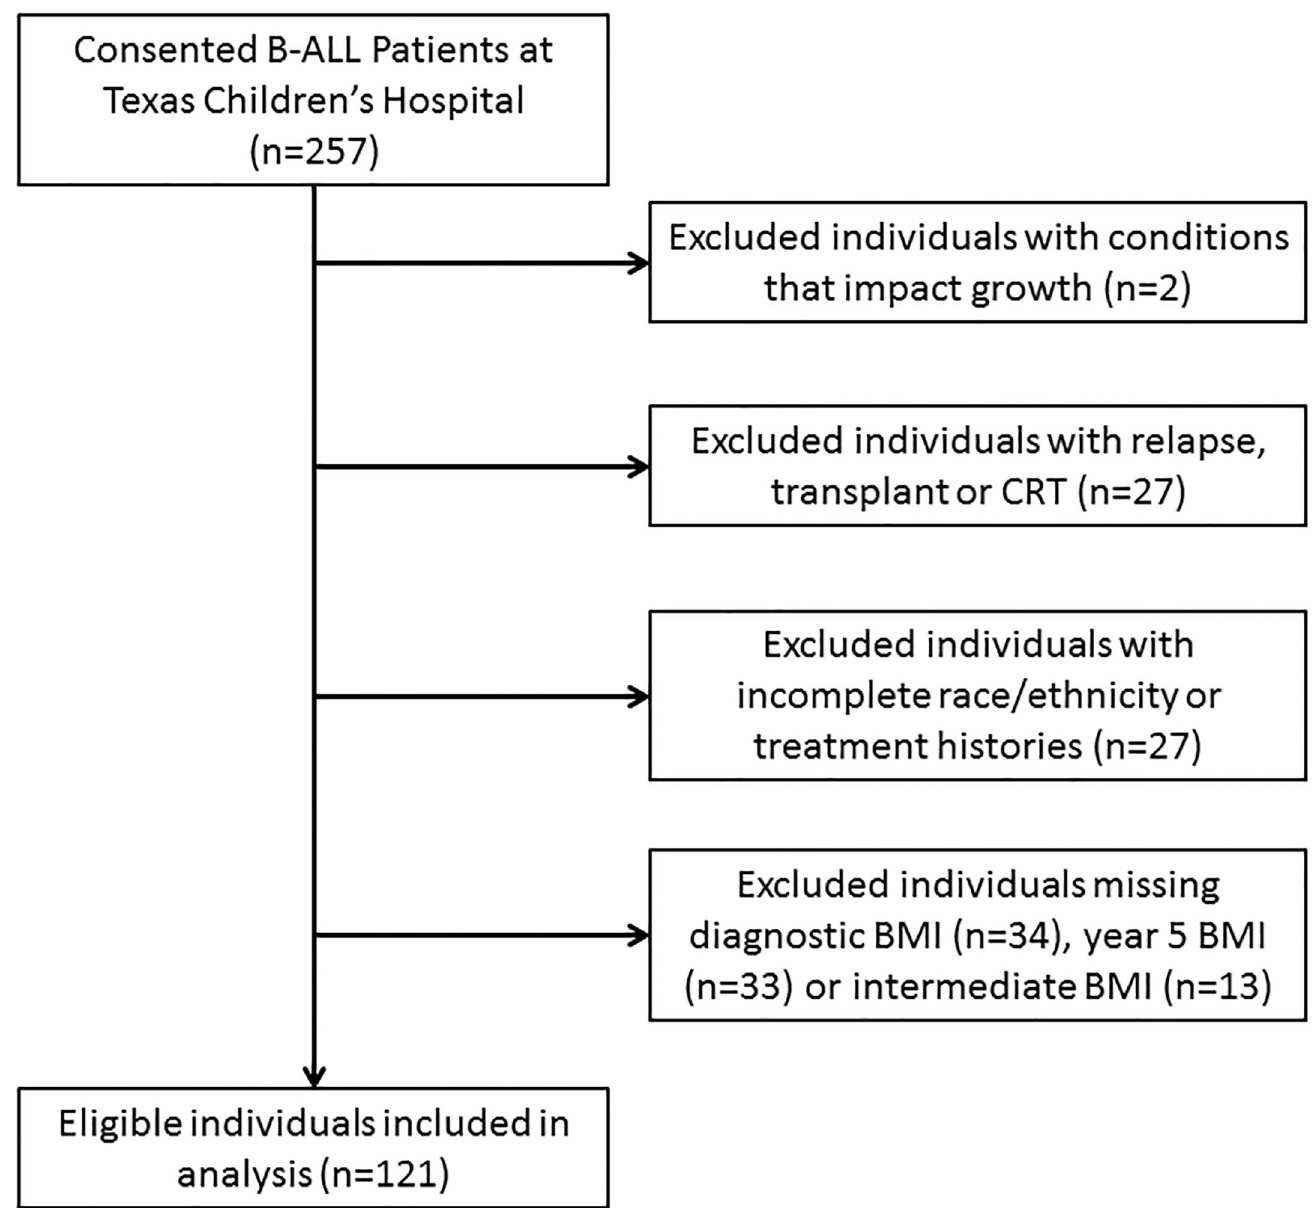
Fig 1. Flow diagram of patient eligibility. https://doi.org/10.1371/journal.pone.0217932.g001 LCGA identified three latent classes of BMI z-score trajectories between diagnosis and five years post-diagnosis (Fig 2B), with 21% of patients (n = 25, group 1) classified in a low BMI z- score trajectory (mean BMI z-score at diagnosis = -0.66), 50% (n = 60, group 2) classified in a moderate BMI z-score trajectory (mean BMI z-score at diagnosis = 0.75), and 30% (n = 36, group 3) classified in a high BMI z-score trajectory (mean BMI z-score at diagnosis = 1.87). On average, the mean BMI z-scores for each group increased between diagnosis and five years post-diagnosis, with a best-fit linear trend for change reaching statistical significance in group 2 (p-value = 0.0047) and group 3 (p-value = 0.0499). Mean BMI z-scores increased rapidly in